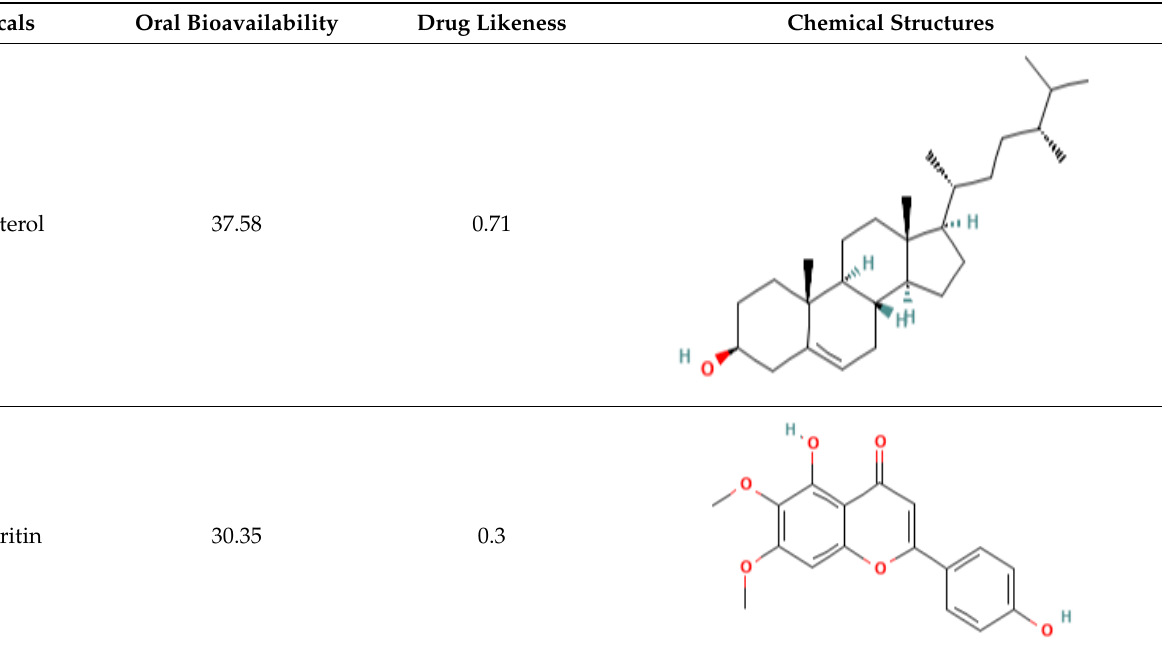
Table 1. OB and DL values of active ingredients of O. sanctum .